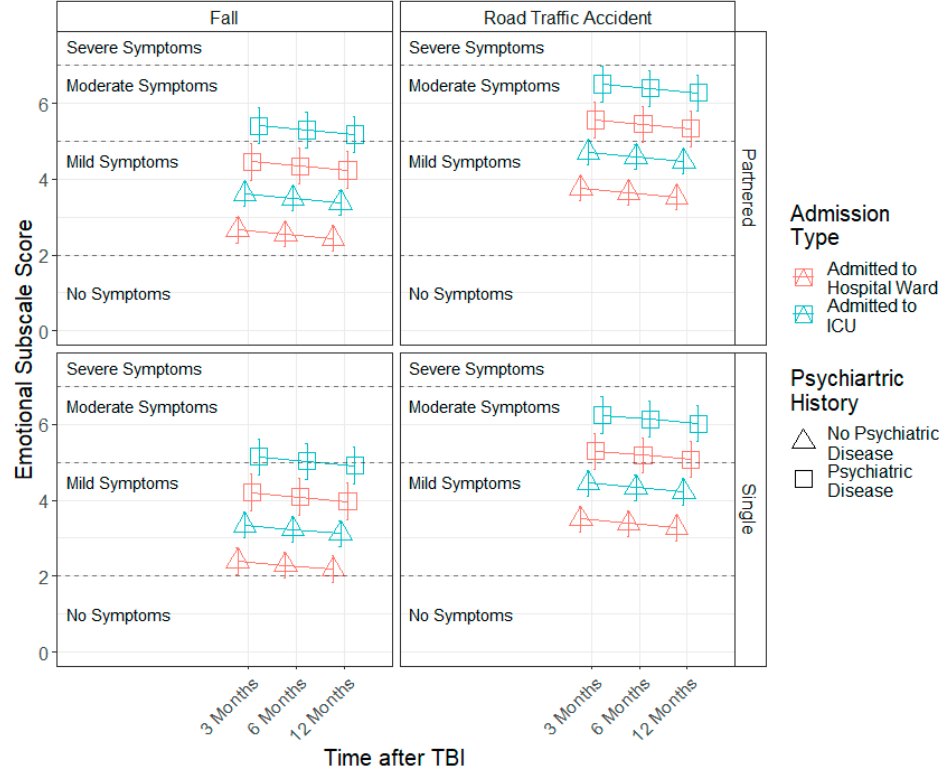
Figure 2. Modelled trajectories for the somatic factor by significant predictors.